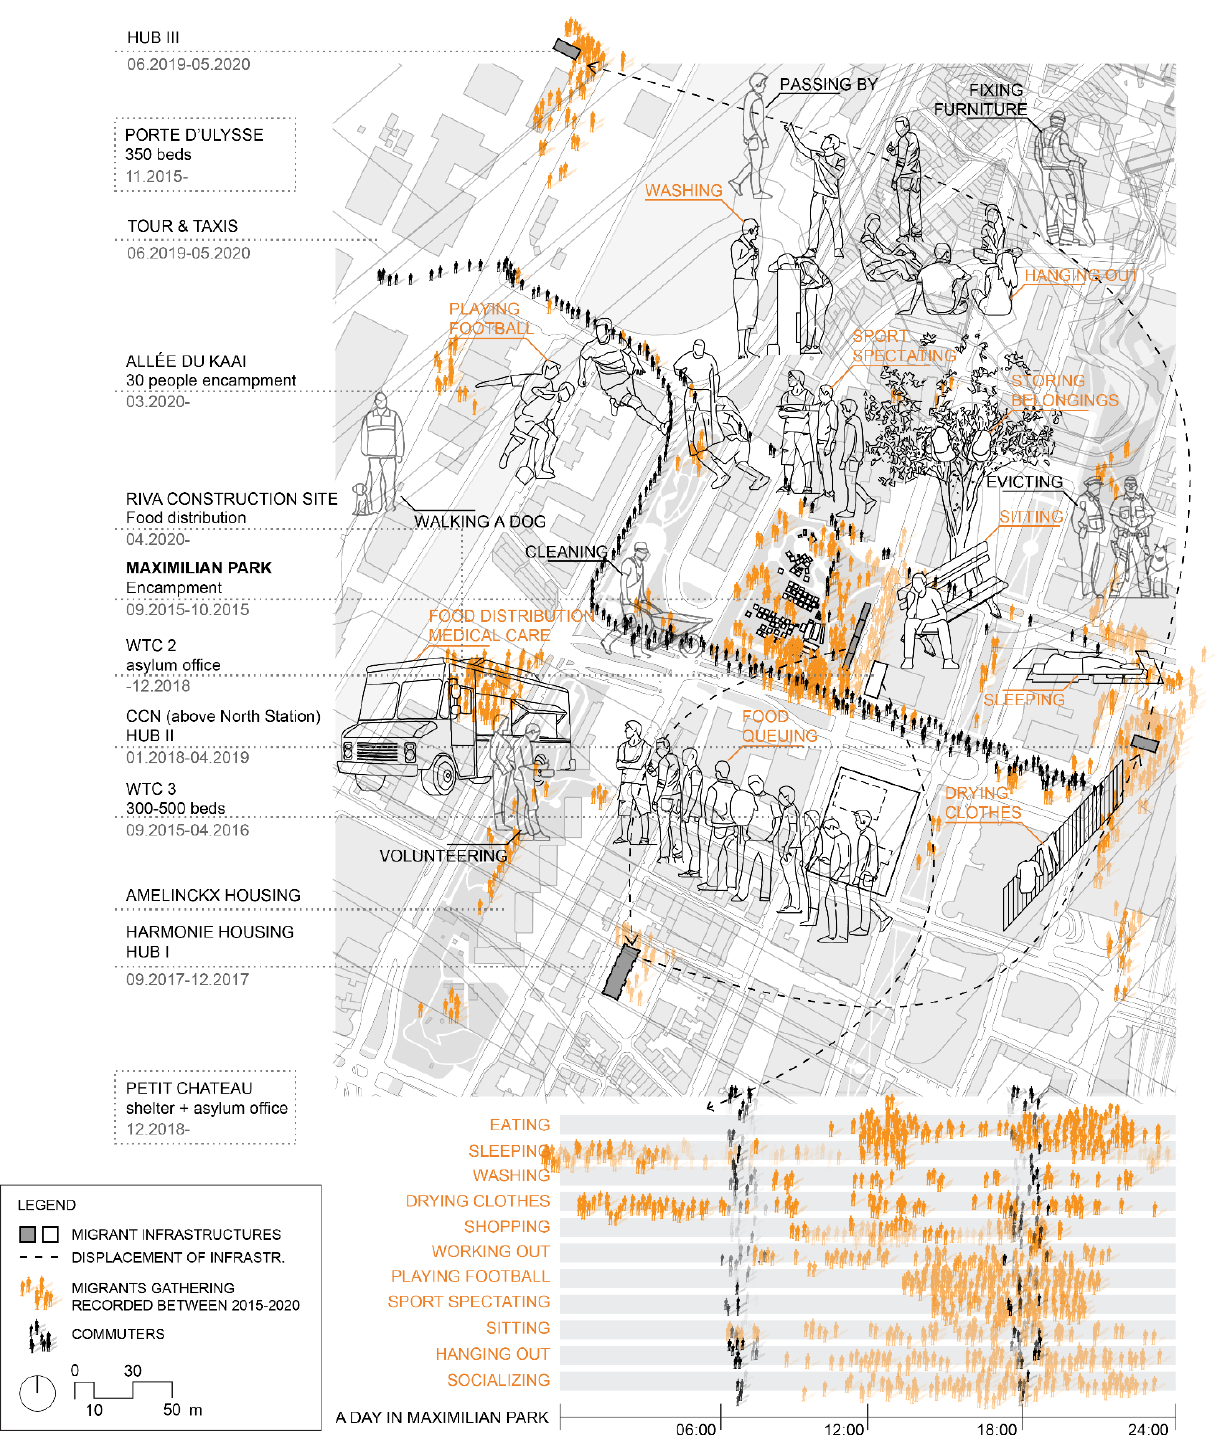
Figure 4. Maximilien Park: Occupation and resignifications. Credits due to the authors based on Daher & Bosmans (2019). Urban Planning, 2020, Volume 5, Issue 2, Pages